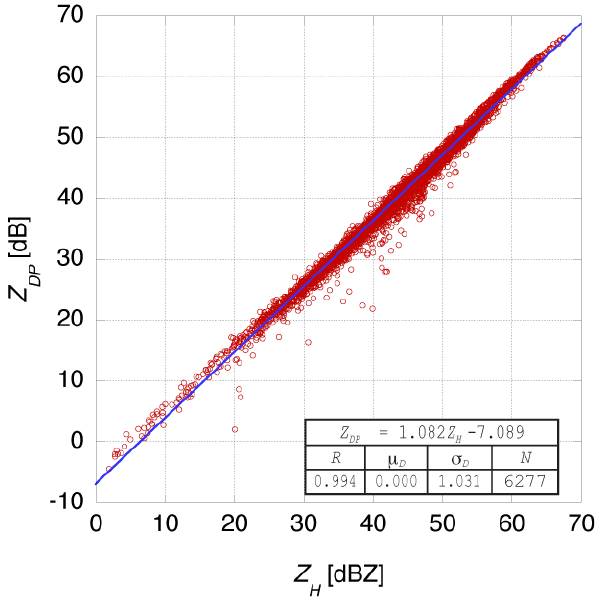
Fig. 3. Scatter plot of the reflectivity factor ( Z H ) vs. the differ- ence reflectivity ( Z DP ) measured in precipitation regions that con- tain rain only at the altitudes between 500m and 4500ma.g.l. at 03:23JST on 7 July 2010. The line represents a linear regression (rain line) as shown in the legend on the bottom with the correlation coefficient, bias, standard deviation and number of samples.